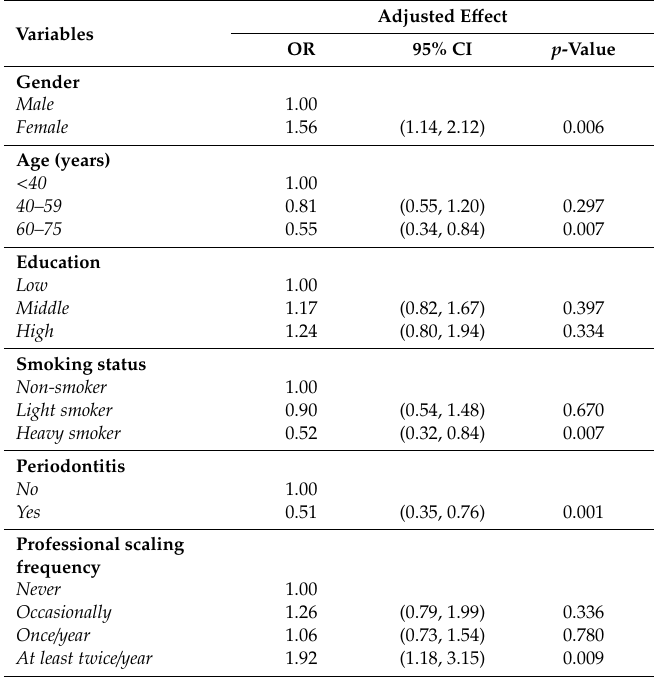
Table 4. Multivariate logistic model, considering self-awareness of oral malodor as the outcome variable (Hosmer and Lemeshow χ 2 = 8.652, df = 8, p =